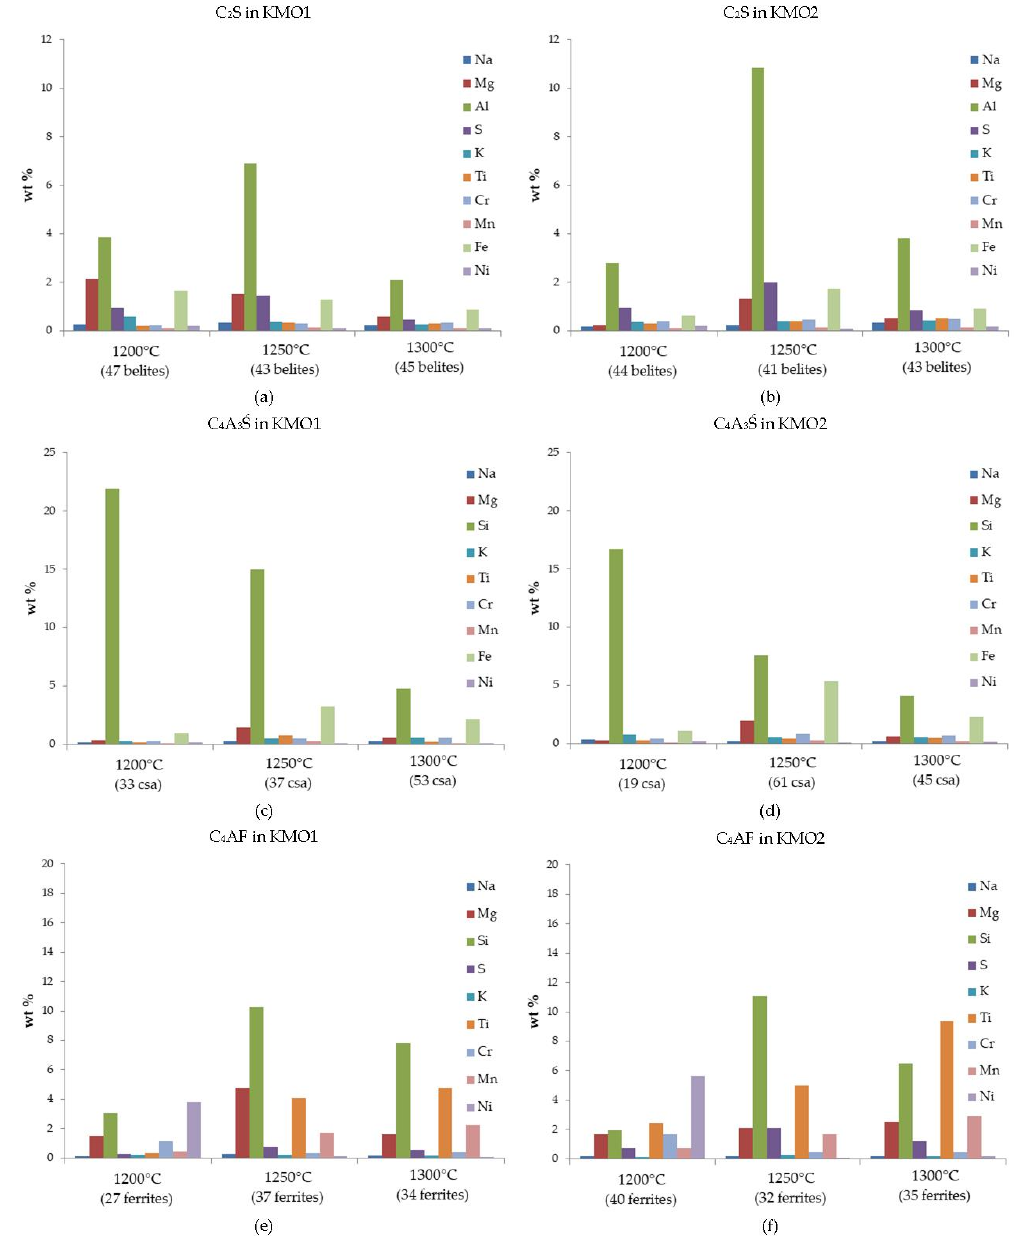
Figure 4. The incorporation of minor elements into the main clinker phases of the KMO1 and KMO2 clinkers sintered at 1200, 1250, and 1300 ◦ C, as determined by EDS analysis (wt.%): ( a ) Belite (C 2 S) in KMO1; ( b ) C 2 S in KMO2; ( c ) calcium sulfoaluminate (C 4 A 3 ´S) in KMO1; ( d ) C 4 A 3 ´S in KMO2; ( e ) ferrite (C 4 AF) in KMO1; and ( f ) C 4 AF in KMO2. The number of grains measured is given below the temperature in each individual diagram.